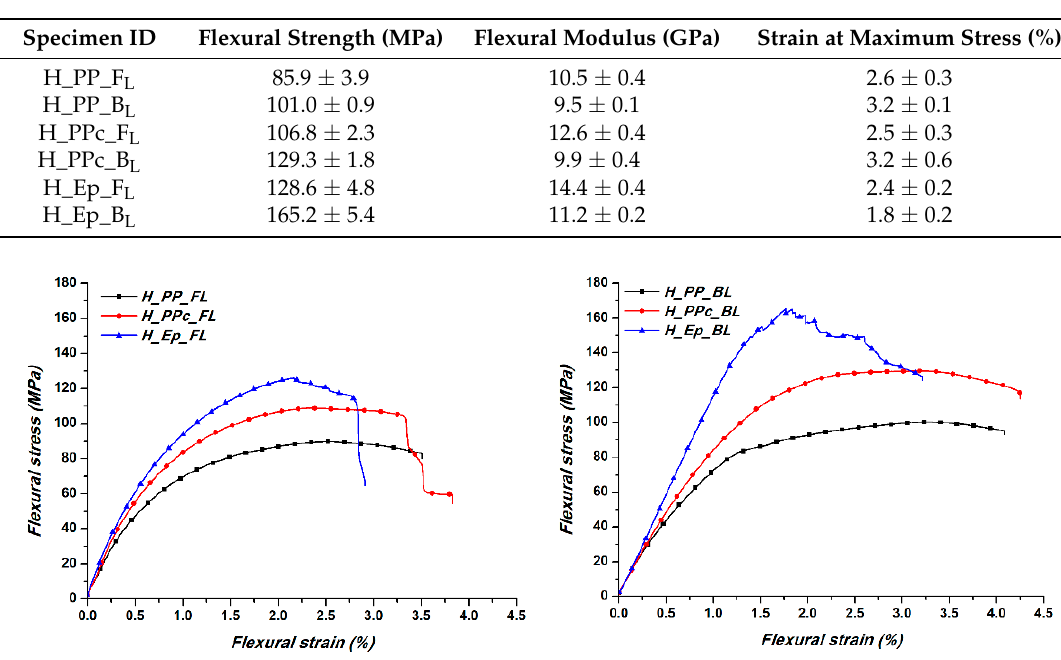
Table 2. Summary of flexural properties of flax/basalt hybrid laminates.